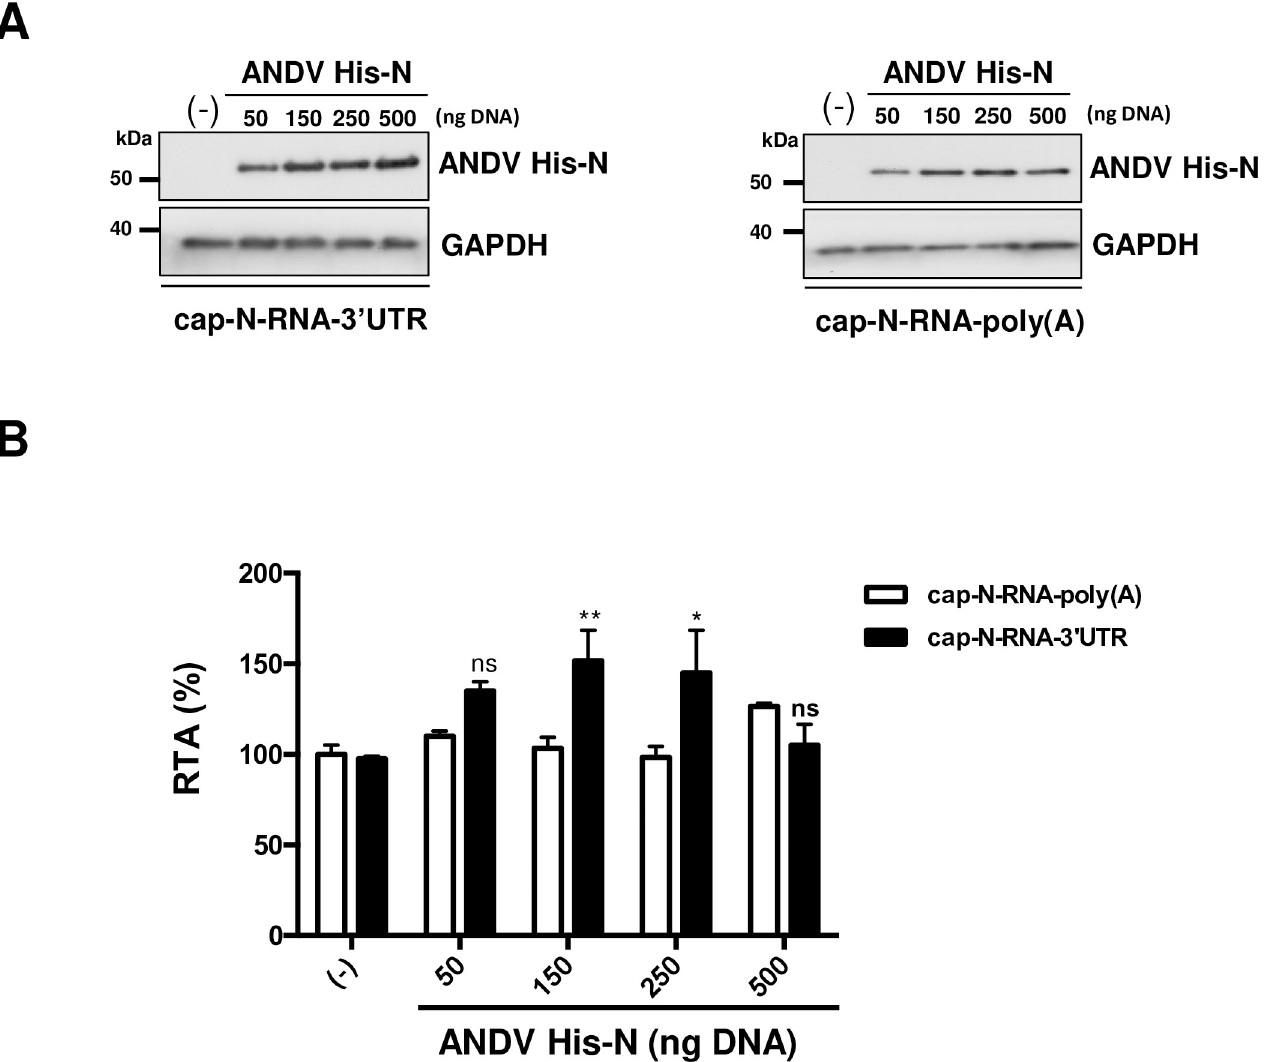
Fig 3. The ANDV-N protein enhances translation of the ANDV-like SmRNA in cells. HEK-293T cells were transfected with increasing amounts (50–500 ng) of a plasmid encoding for the recombinant ANDV His-N protein. Total transfected DNA was kept constant at 500 ng using pSP64 Poly(A) DNA. In vitro transcribed cap-N-RNA-3’UTR or cap-N-RNA-poly(A) RNAs, were transfected in cells together with a capped and polyadenylated mRNA encoding for RLuc (RLuc RNA). Six hours post-transfection (hpt), cells were lysed, and FLuc and RLuc activities were measured. (A) Expression of the ANDV His-N protein was confirmed by western blotting, using a monoclonal mouse anti-His antibody. GAPDH was used as a loading control. ( B) The FLuc and RLuc activities were used to determine the relative translation efficiency (RTA), FLuc/RLuc, for each mRNA. Values shown are the mean (+/- SEM) of at least three independent experiments, each conducted in triplicate. Statistical analysis was performed by a two-way ANOVA with Sidak’s multiple comparisons test (P < 0.05). hours post-infection, the expression of the ANDV-N and the endogenous eIF4G protein was evaluated by immunofluorescence (IF) (Fig 4A). The endogenous eIF4G protein showed a dif- fuse cytoplasmic distribution, while the distribution of the ANDV-N was also cytoplasmic but predominantly peri-nuclear (Fig 4A). We then performed an in situ proximity ligation assay (PLA) [40,41], using a rabbit anti-eIF4G and a mouse anti-ANDV-N as primary antibodies (Fig 4B). PLA recognizes target molecules in close proximity ( < 40 nm), and a positive signal is considered to reflect a protein-protein interaction [40,41]. ANDV-infected cells developed using only the secondary antibodies were used as negative controls (Fig 4A and 4B, panel’s